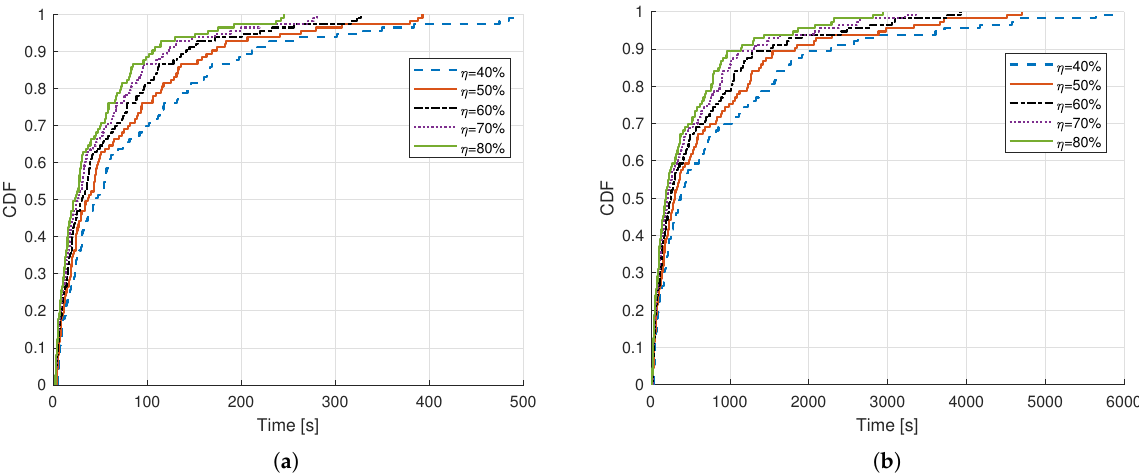
Figure 7. CDF of time required for energy harvesting at outdoor LoRa backscatter device with different energy harvest efficiencies at, ( a ) 200MHz, ( b )